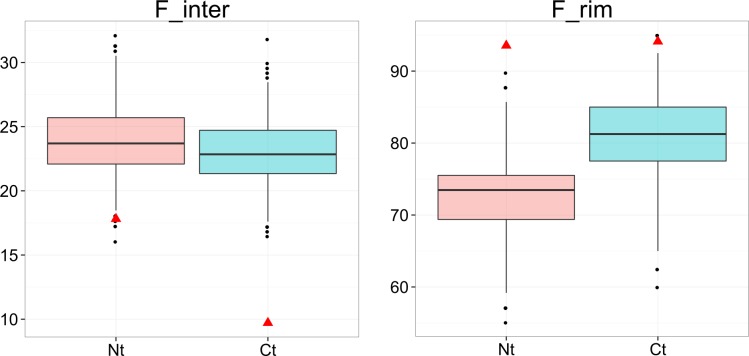
Terminal residues are underrepresented in protein-DNA interfaces, but when involved in interfaces, they are over-represented in rim regions.Data are collected on a list of 303 protein-DNA complexes, non-redundant at the 70% level. F_inter: fraction of terminal residues in interfaces. F_rim: fraction of terminal residues in rim regions, among those in interfaces. Each box plot displays the distribution of simulated values computed from 1000 random data sets. Box edges correspond to the 25th and 75th percentiles, the notches extend from the 1st to the 99th percentiles, and black points are outliers. Observed fractions are depicted as red triangles.